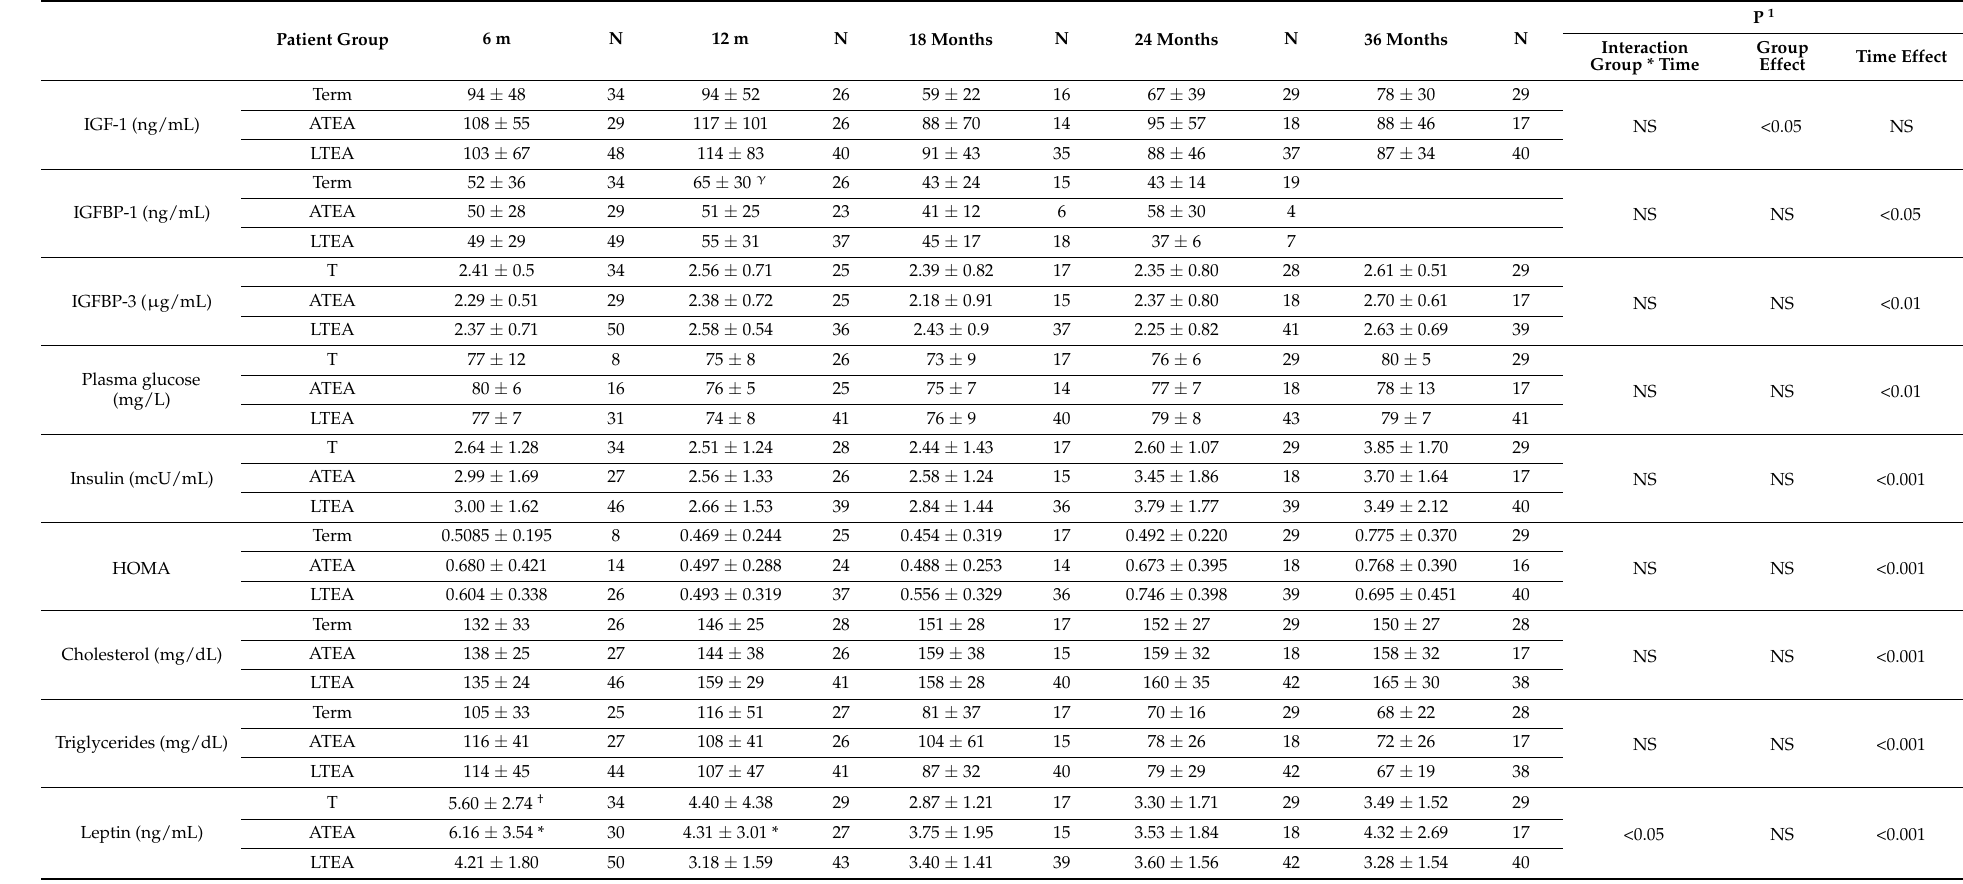
Table 5. Comparison of cholesterol and triglycerides, adipokines, interleukin 6, IGF family, glucose tolerance parameters, and cortisol between term, LTEA, and ATEA infants. Patient